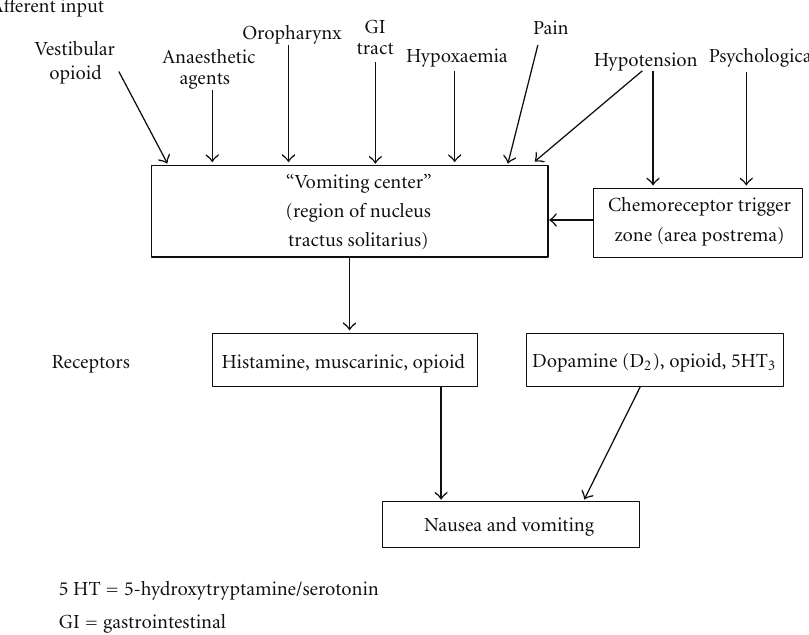
Figure 1: The inputs and receptors involved in causing PONV. 5 HT: 5- hydroxytryptamine/serotonin; GI: gastrointestinal.